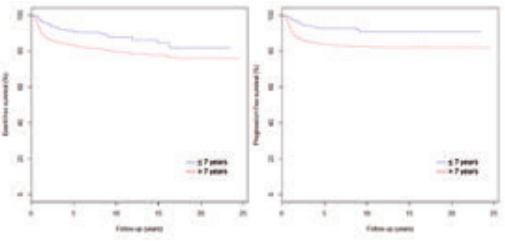
Figura 1. Curve di Kaplan-Meier per EFS and PFS nei 2 gruppi di età di pazienti con